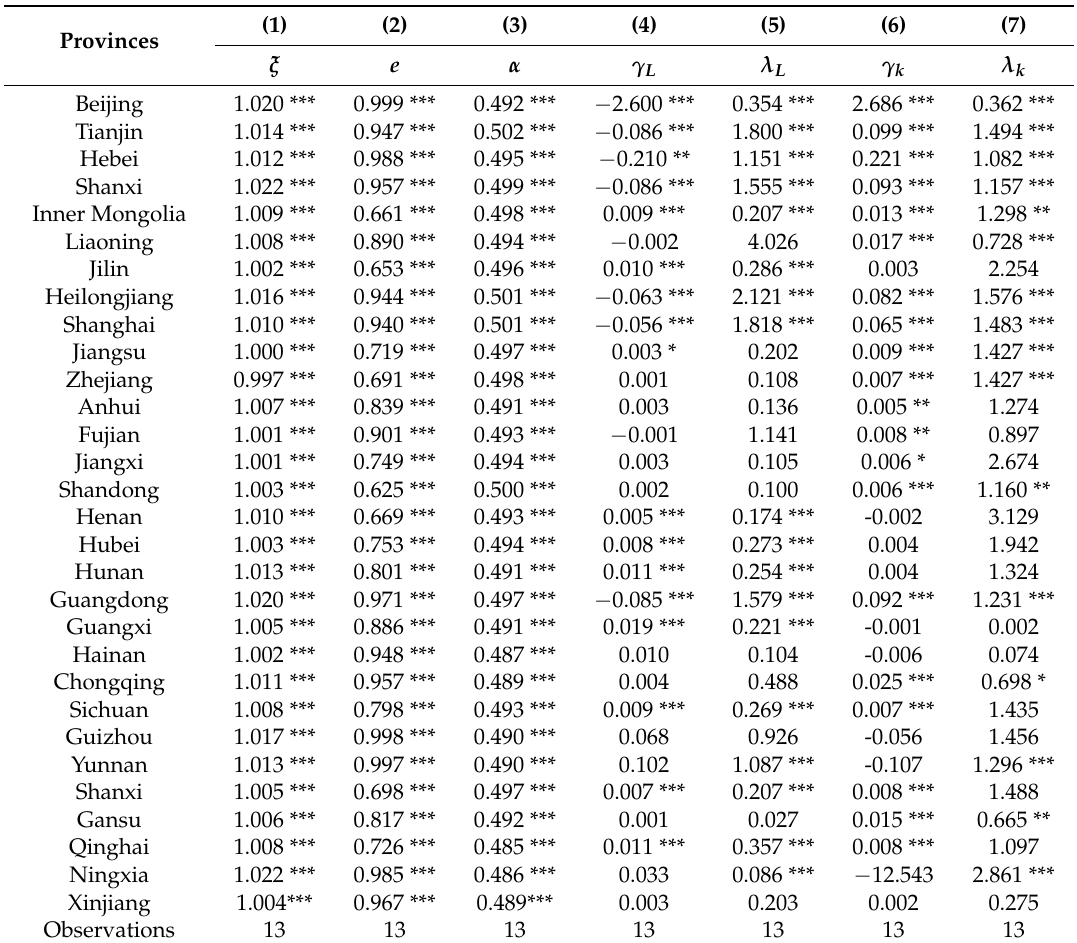
Table 2. Estimated